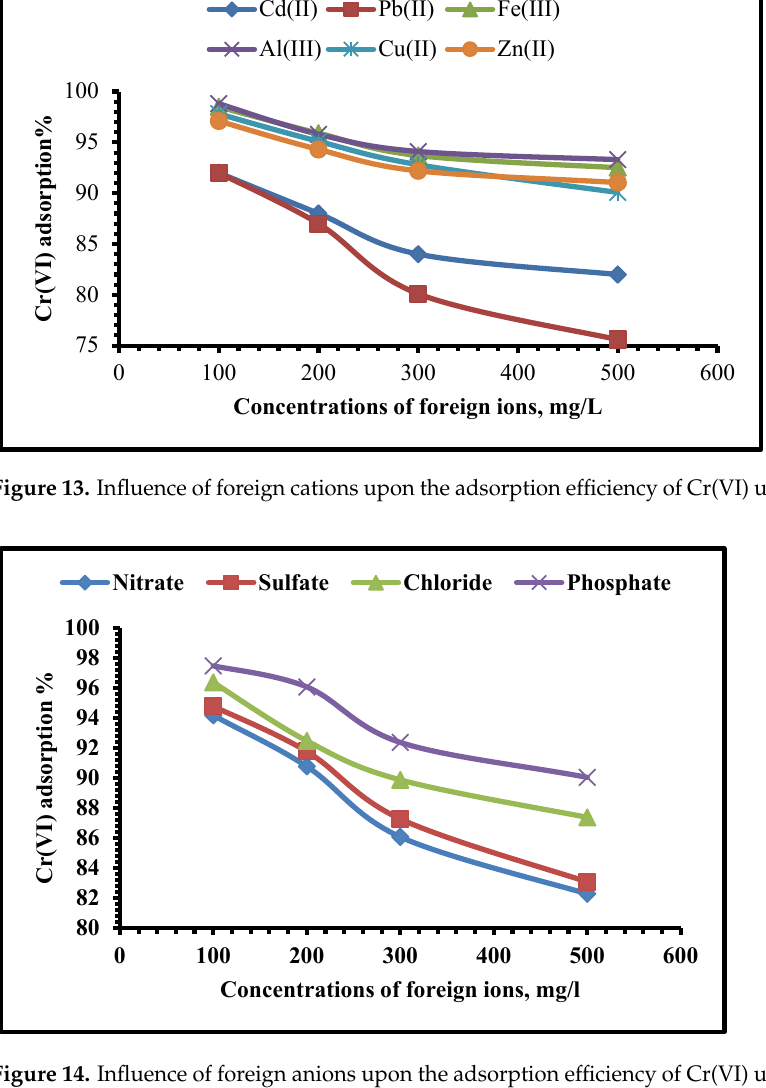
Figure 14. Influence of foreign anions upon the adsorption efficiency of Cr(VI) using TIHP adsor ‐ bent.